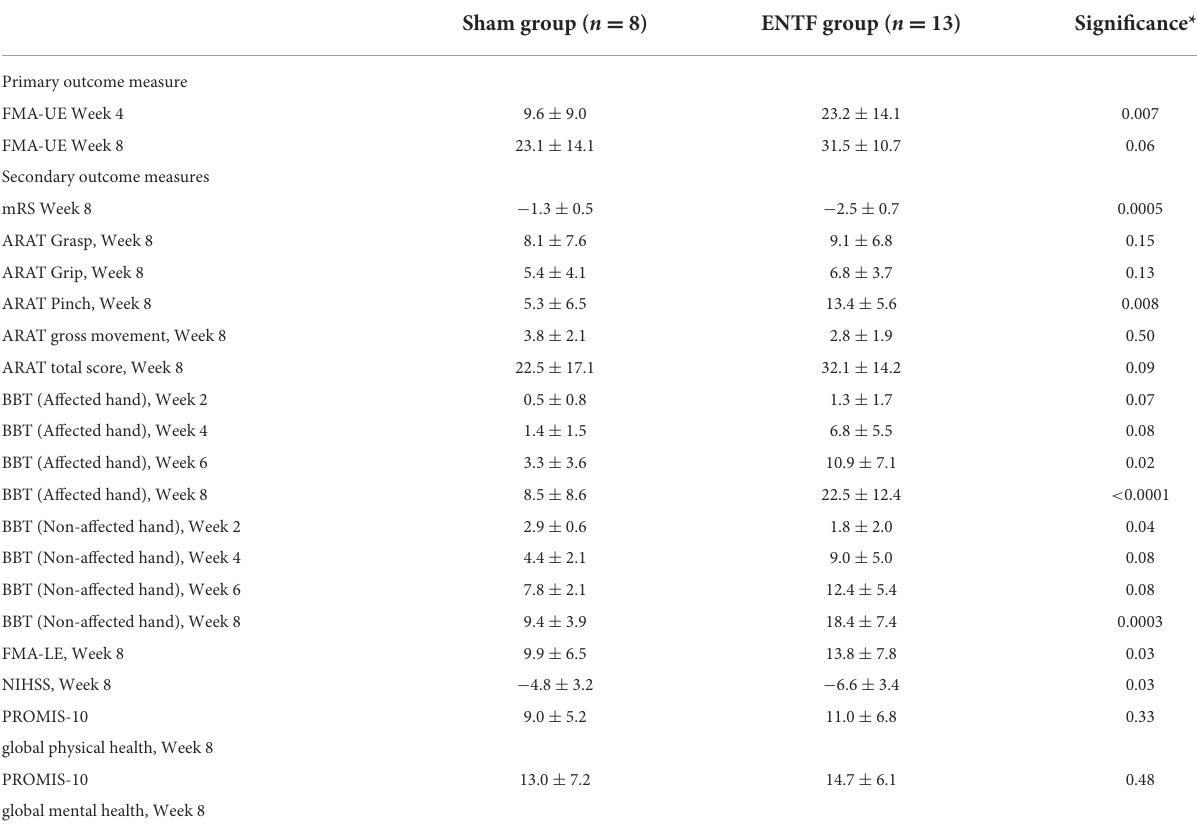
TABLE 2 Efficacy outcome measures * . Sham group ( n = 8) ENTF group ( n = 13)